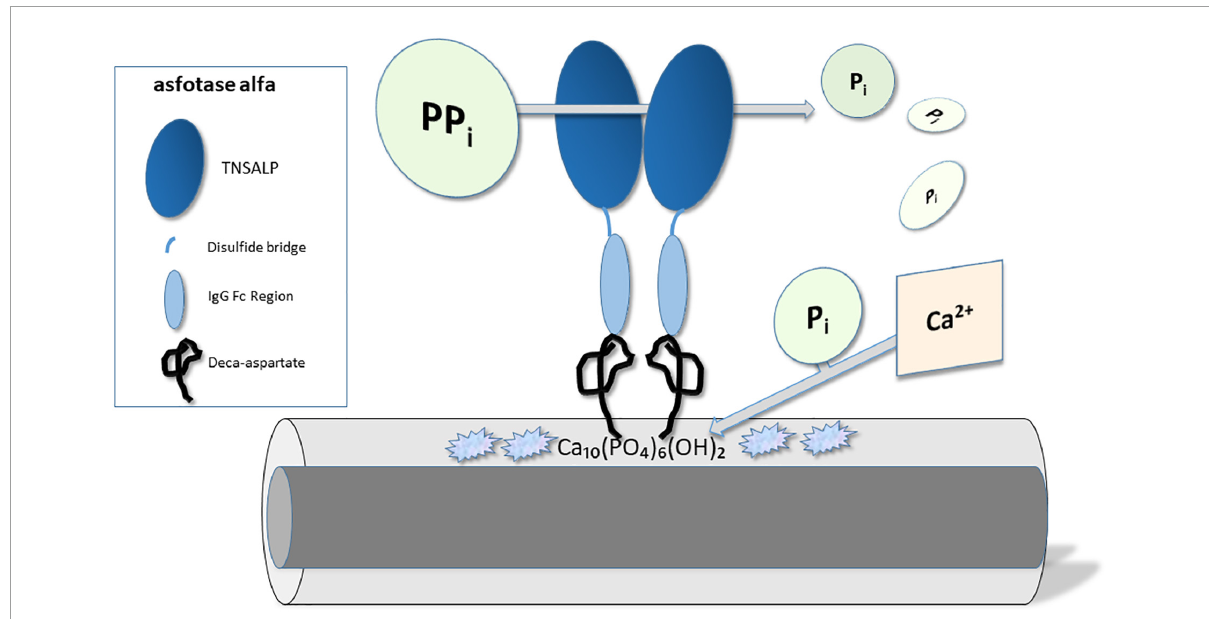
FIGURE1 Molecular mechanism of action – Asfotase alfa. Asfotase alfa consists of the tissue non-specific alkaline phosphatase (TNSALP) enzyme linked to the human IgG Fc domain and a terminal deca-aspartate peptide which enhances targeting to hydroxyapatite Ca 10 (PO 4 ) 6 (OH) 2 crystals. TNSALP catalyzes the degradation of pyrophosphate (PPi) into inorganic phosphate (Pi), which in turn can bind calcium, form hydroxyapatite, and improve bone